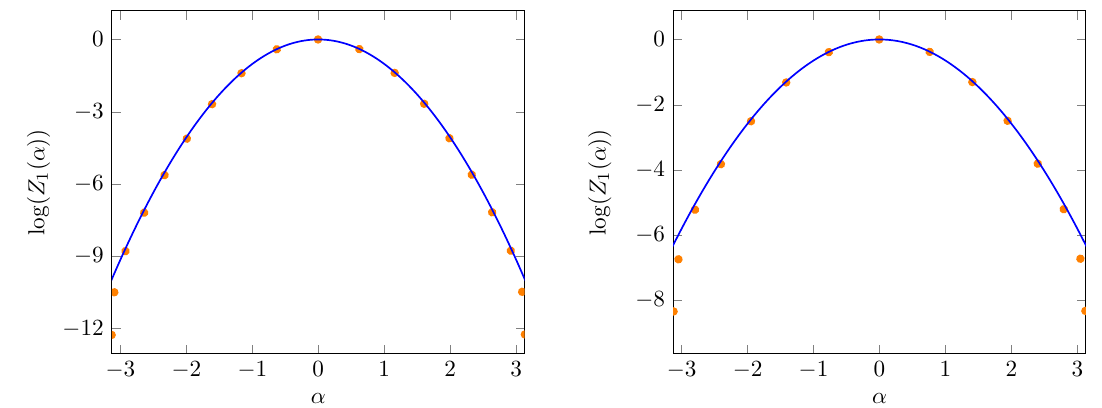
Figure 2 . Logarithm of the charged moment log( Z 1 ( α )) evaluated for a subsystem made of two intervals of length 0 . 1 L, 0 . 3 L , separated by a distance ∆ x = 0 . 2 L , at β = 0 . 1 L . The blue solid line corresponds to eq. (3.21) while the lattice cutoff (cid:15) is given by eq. (3.28). We have set the number of lattice sites N = 300